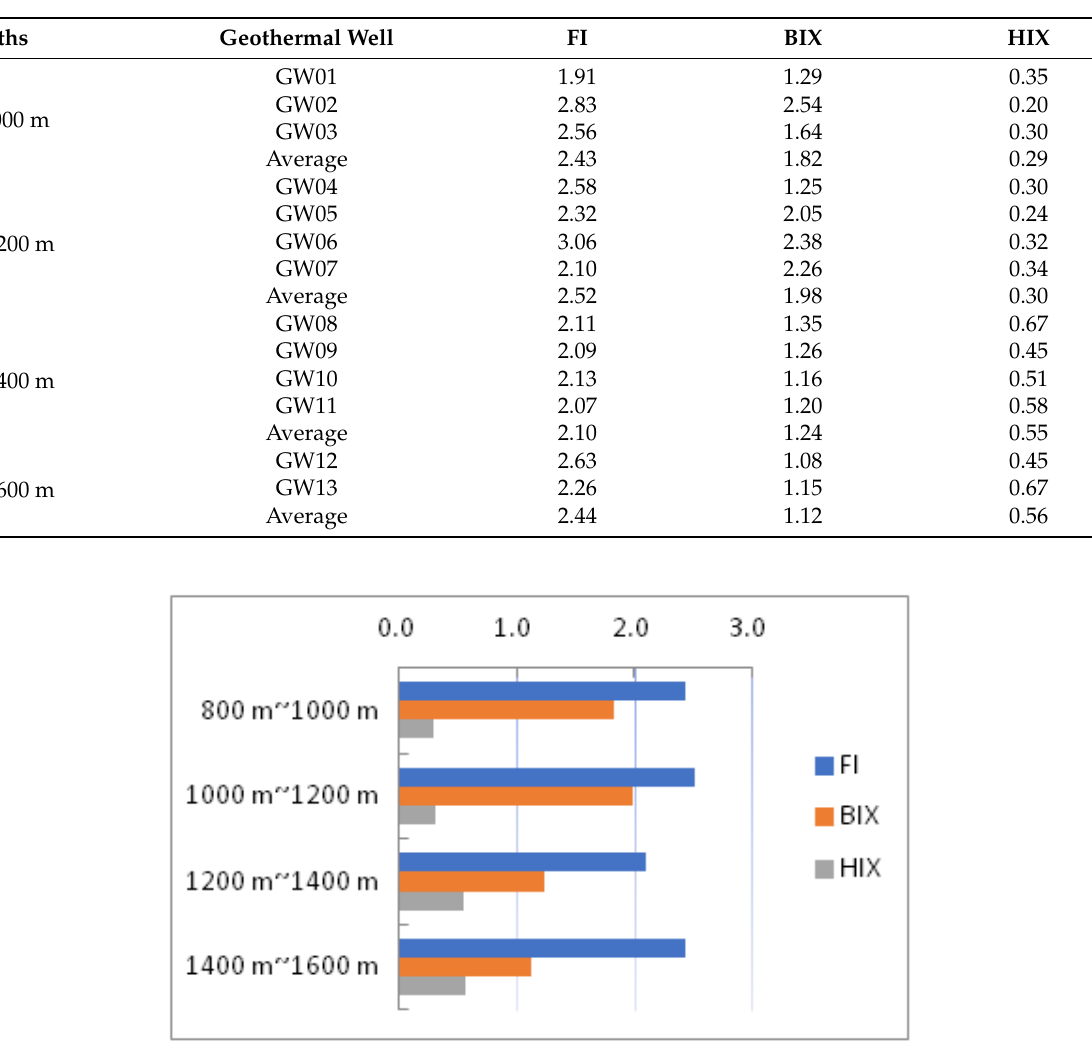
Figure 2. Dissolved organic matter (DOM) fluorescence spectra parameters (FI: fluorescence index, BIX: biological index, HIX: humification index) in geothermal water from different reservoirs.